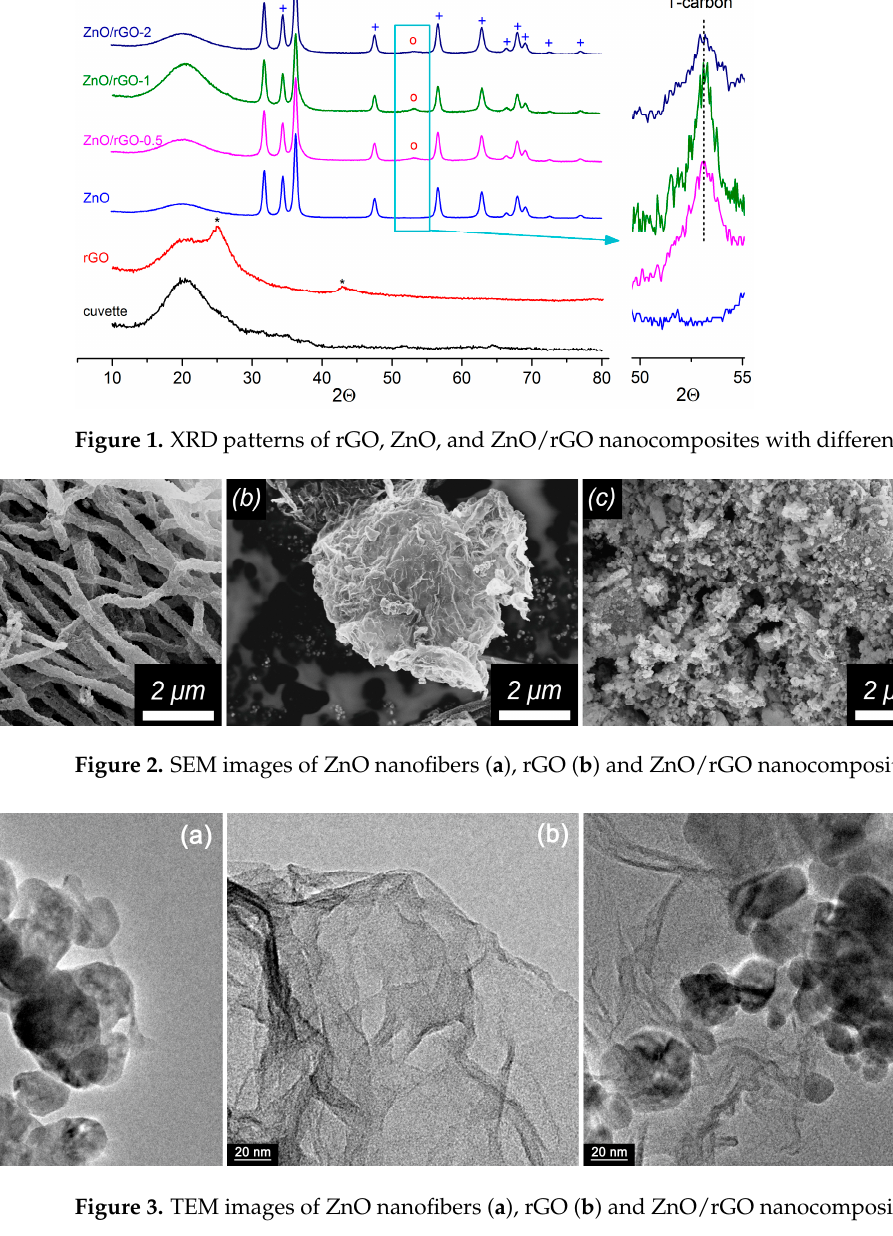
Figure 3. TEM images of ZnO nano fi bers ( a ), rGO ( b ) and ZnO/rGO nanocomposite ( c ).